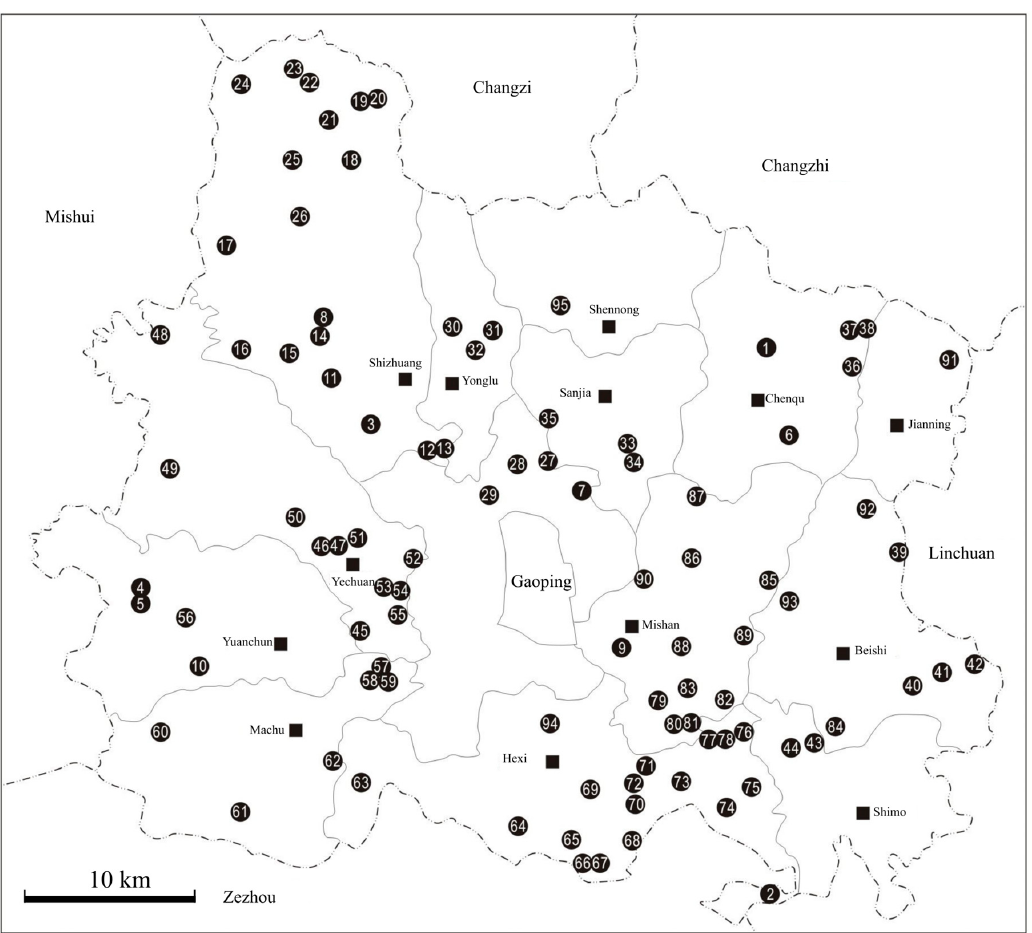
Figure 1. A distribution map of the extant frescoes in the temples of Gaoping County.